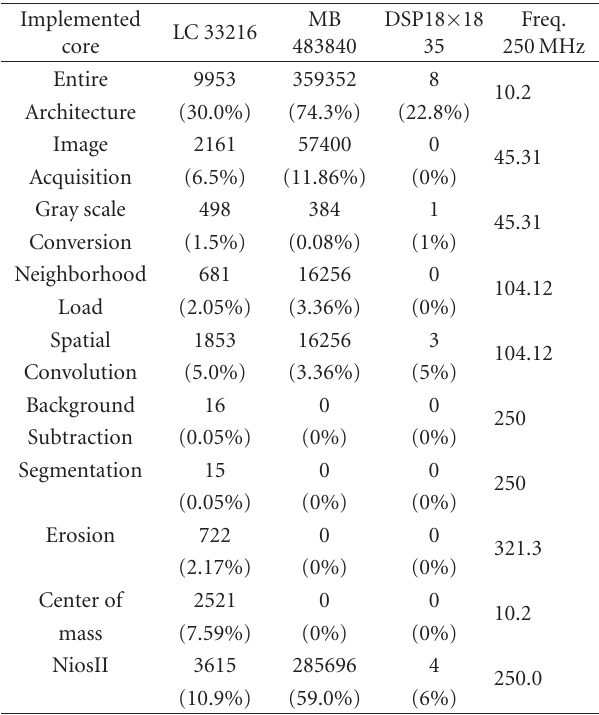
Table 3: Synthesis results (chip ep2c35f672c6).